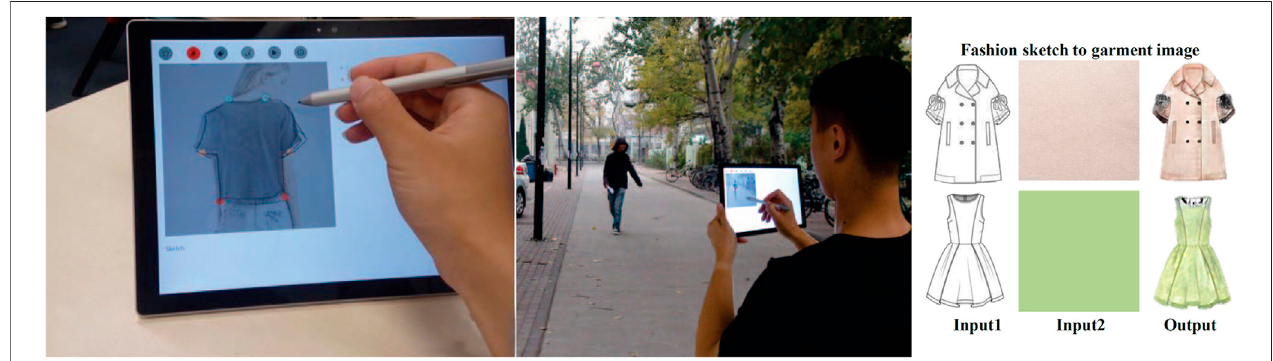
FIGURE9|Left: TheinterfacedesignedbyZhaoandMa(2018)inaction,anARsystemfor insitu fashiondesign. Right: Whendesigning,itcanbecumbersometo iterate overall the possible material options. Cui et al. (2018) presented a system that attempts to optimize the process.